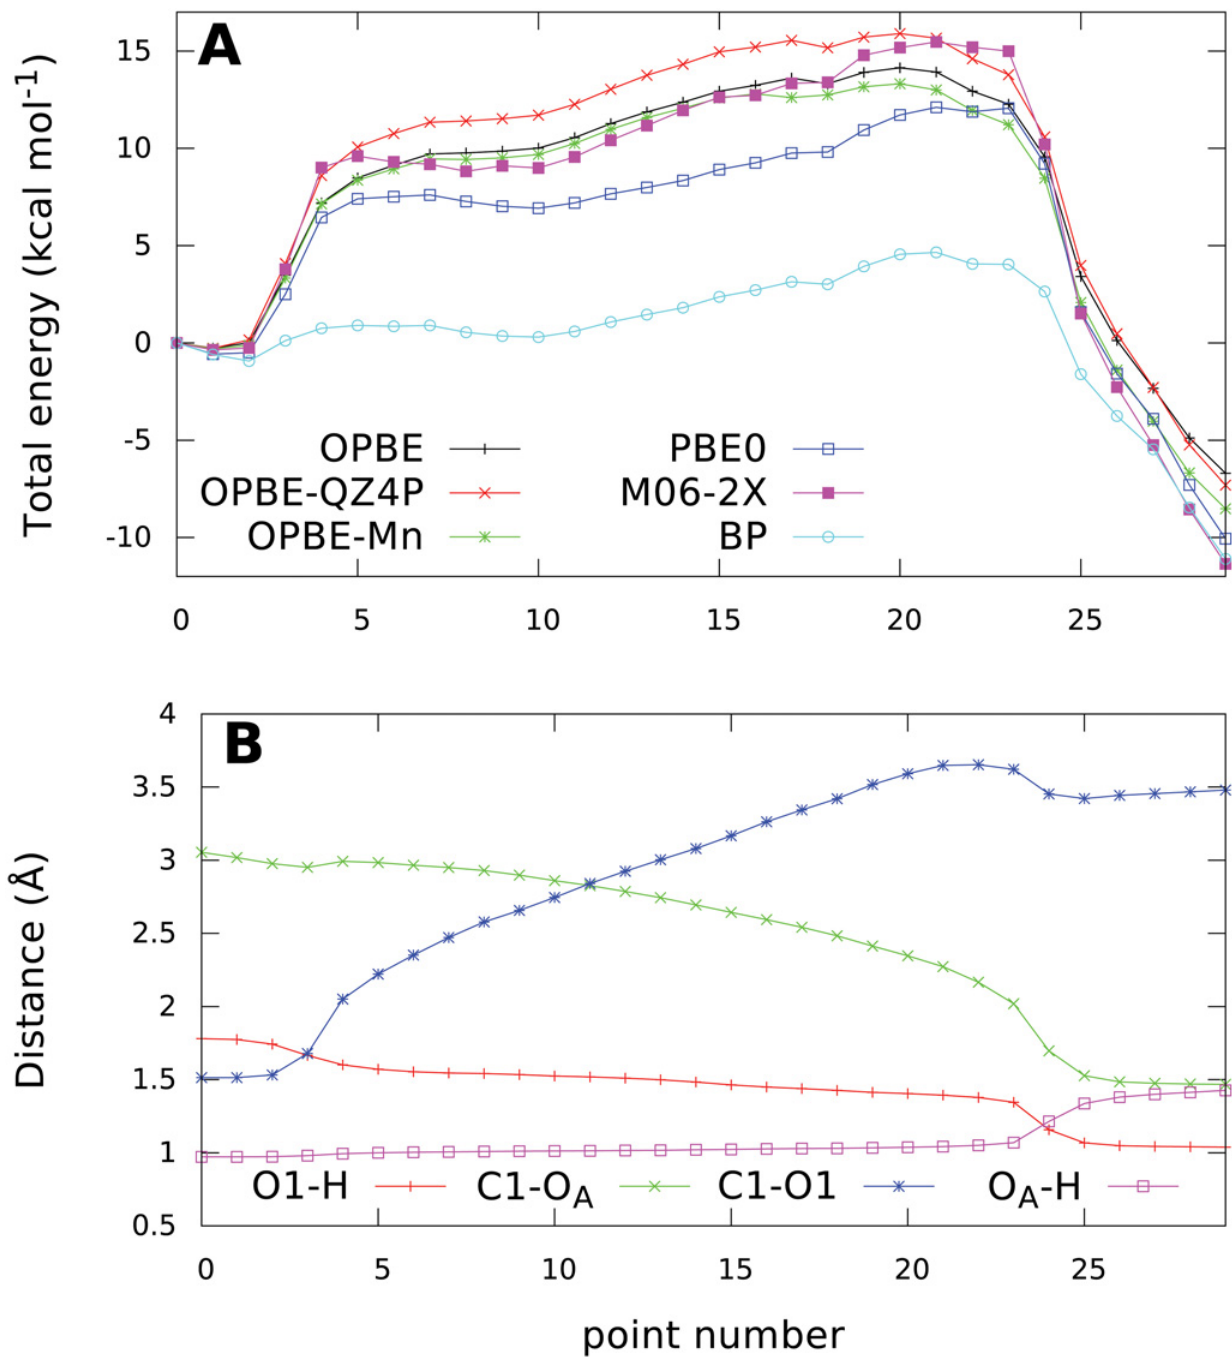
Fig 5. Evolution of potential energy calculated using different methods (A) and key bond lenghts (B) along the NEB path. All energies are relative to the reactant state (point 0).